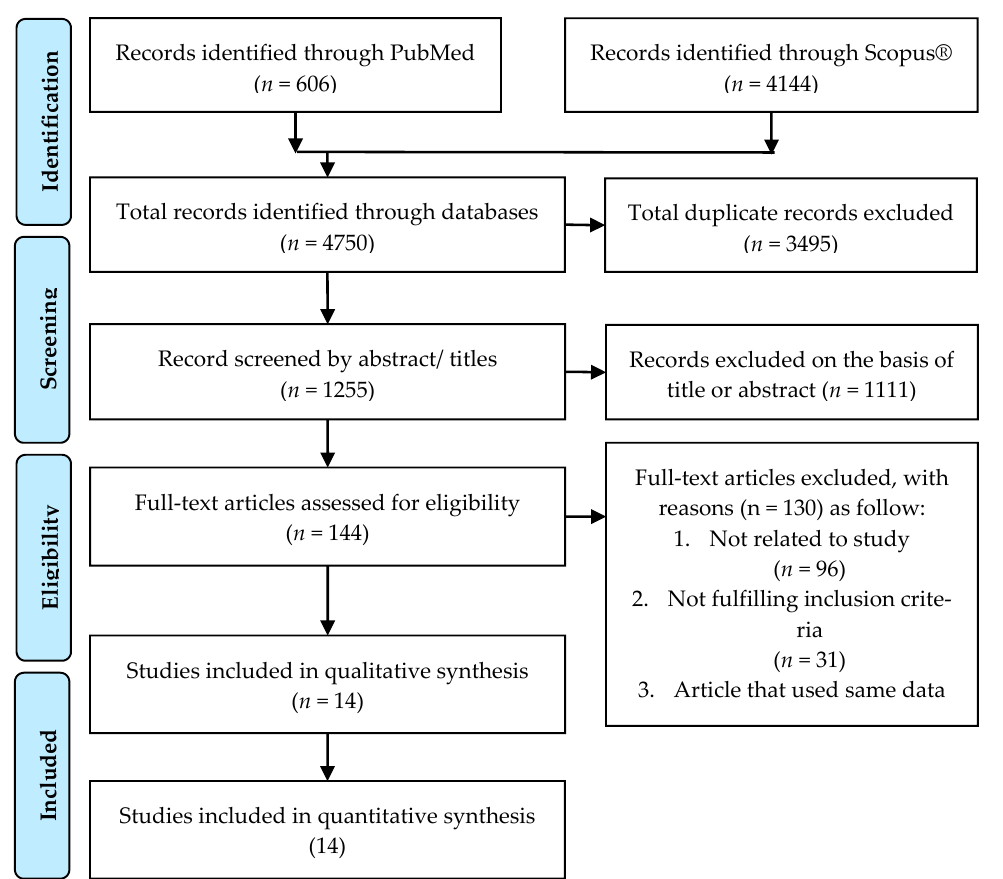
Figure 1. PRISMA flowchart and search strategy.